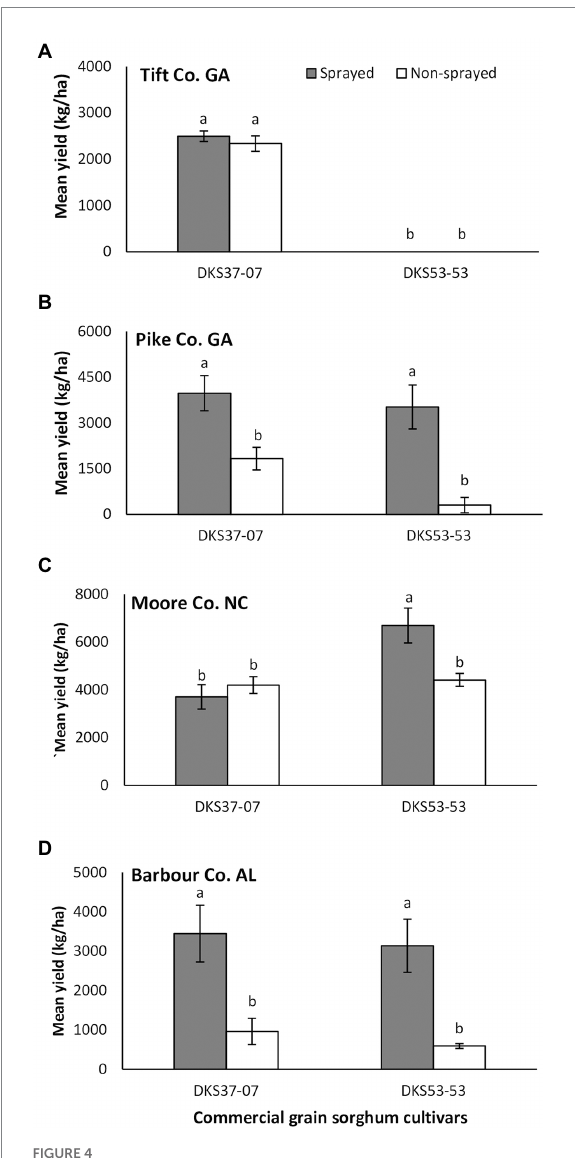
FIGURE 4 Mean (±SE) grain yield (kg/ha) as a function of sorghum cultivar and flupyradifurone foliar application at Tift Co., Pike Co. GA, Moore Co. NC and Barbour Co. AL. Means capped with different letters are significantly different ( p < 0.05; Turkey’s test) among all four treatments. Note that y-axis scales are different on each